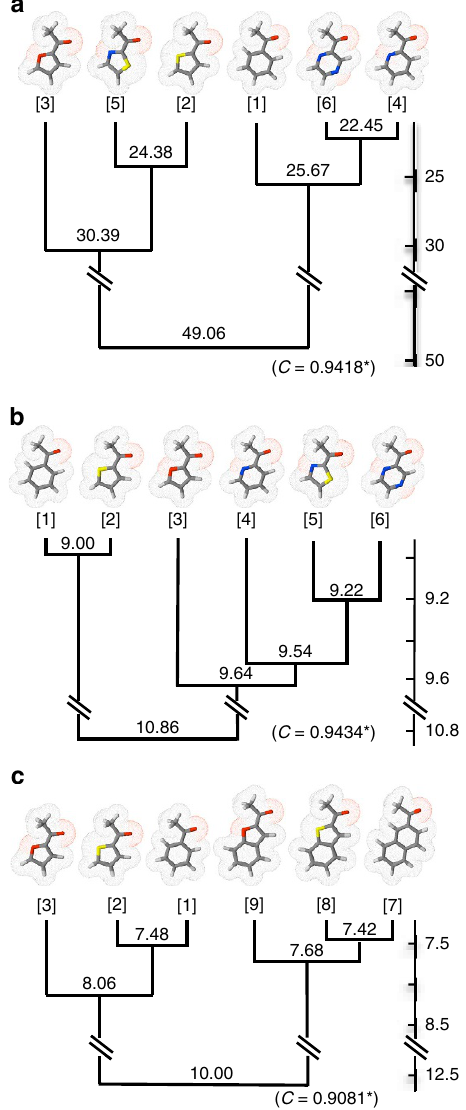
Figure 3 | Hierarchical clustering analysis of Panel 1 and Panel 2 odorants. ( a ) Panel 1 odorants clustered according to chemical similarity as evaluated by 1,666 molecular descriptors downloaded through the e-dragon applet. ( b ) Panel 1 odorants clustered according to biological response similarity based on calcium imaging of dissociated OSNs. Note that in the chemical-based clustering the major division is on ring size while in the biological-based clustering the major division is on the TPSA. ( c ) Panel 2 odorants clustered according to their biological responses, as in b . Although there is a major division based on the presence of a double-ring scaffold, within each branch further subdivisions follow the TPSA rule as in b . *Cophenetic correlation coefficient. All distances in the dendrograms are Euclidian. See online methods for details of dendrogram